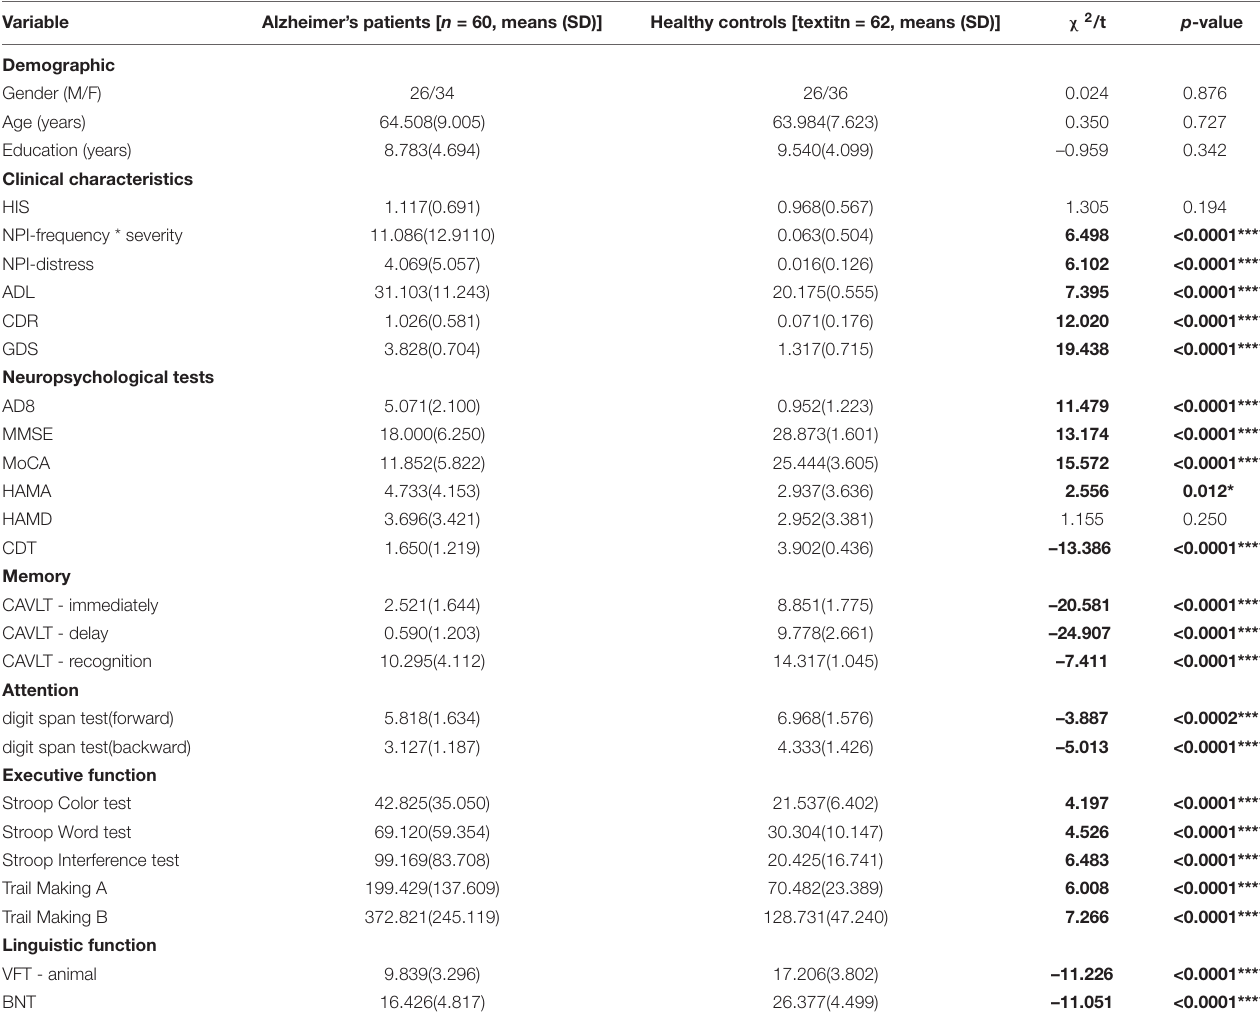
TABLE 1 | The demographic and clinical characteristics and neuropsychological test results of the Alzheimer’s Patients and normal controls in the cross-sectional study.